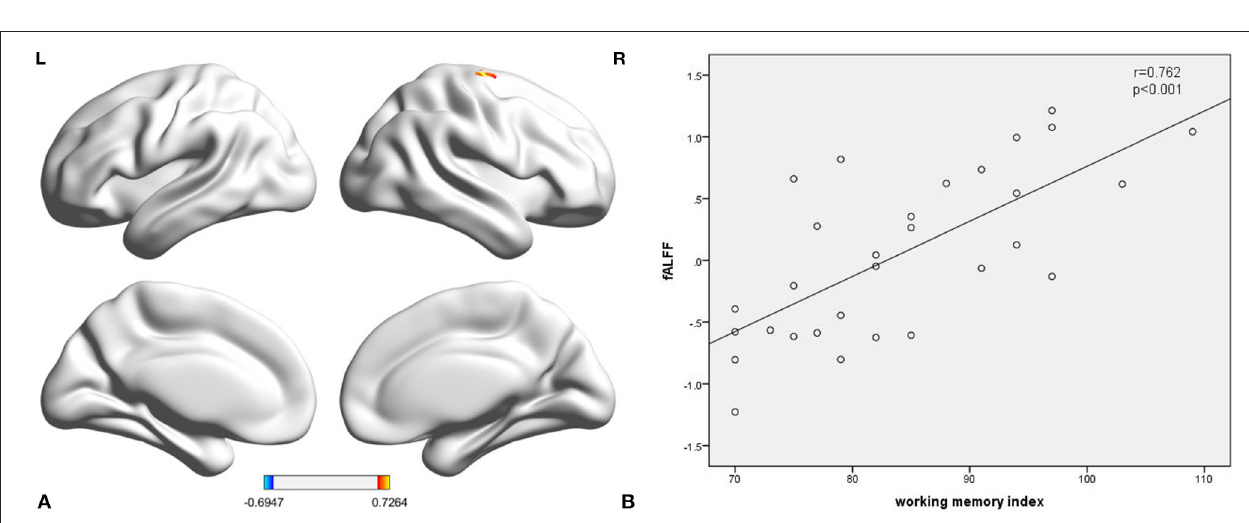
FIGURE 1 | Compared with C-allele carriers, the TT homozygous had decreased ReHo in the right MOG and increased ReHo in the right SFG (A) ; the TT homozygous had reduced FC in the right MOG and right cerebellum (B) , and the TT homozygous had reduced FC in the right SFG and angular (C) . ADHD, attention deficit hyperactivity disorder; FC, functional connectivity; MOG, middle occipital gyrus; ReHo, regional homogeneity; SFG, superior frontal gyrus.